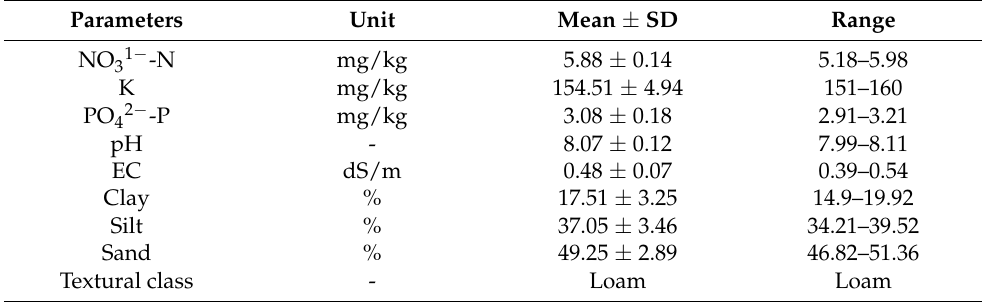
Table 2. Physico-chemical properties of soil at the experimental site ( n = 10).